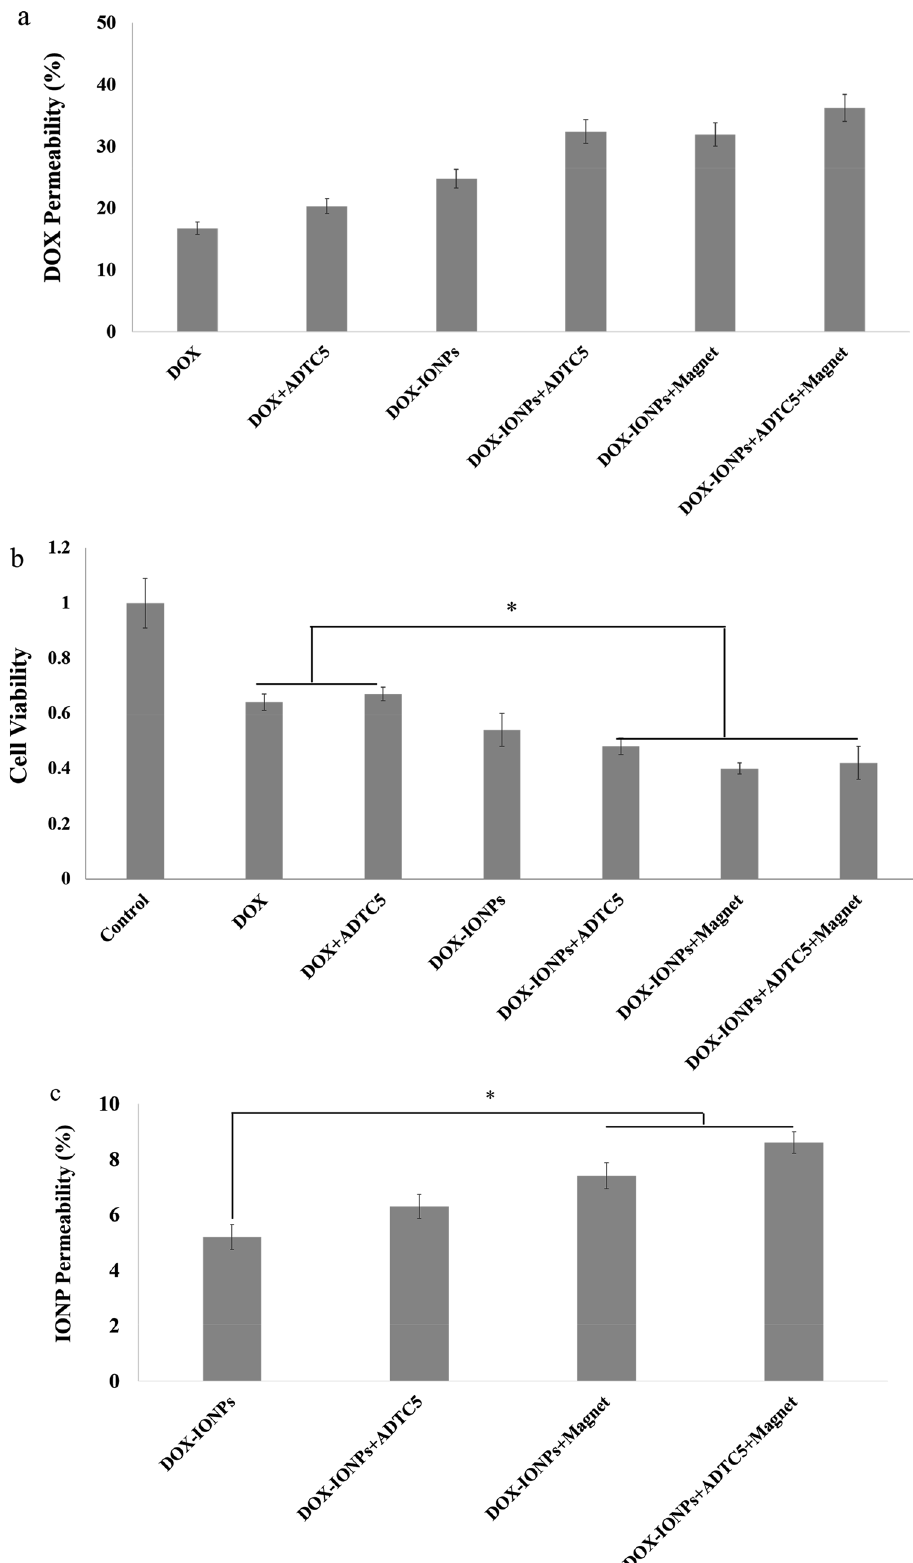
Figure 11. Anti-cancer efficacy of DOX-EDT-IONPs compared to the free DOX on an MDCK-MDR-GBM model in vitro. ( a ) DOX permeability across the MDCK-MDR1 monolayer with or without IONPs in the presence or absence of magnet and ADTC5 ( b ) cytotoxicity of each formulation on U251 cells after penetrating the monolayer. ( c ) DOX-IONPs permeability across the MDCK-MDR1 monolayer with or without magnet and ADTC5. *Indicates a significant difference at p < 0.05 with the other treated groups. Data is presented as mean ± S.D, and n = 3. IONPs and DOX-IONPs represent for EDT-IONPs and